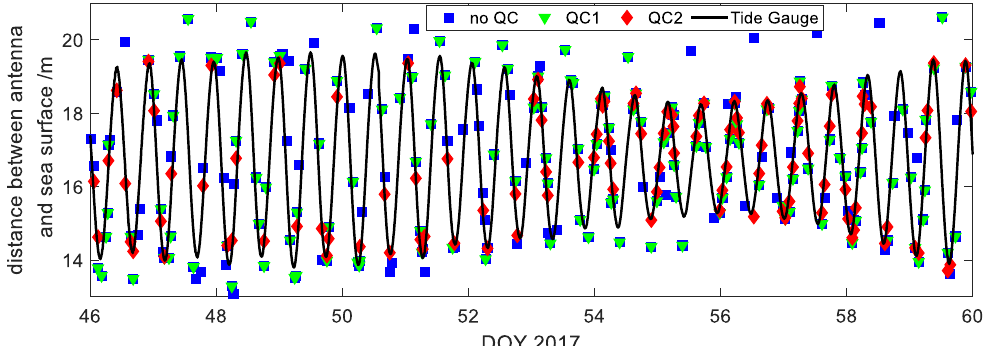
Figure 8. Comparison of different quality control methods for water level inversion at BRST Station. No QC means no quality control, QC1 refers to the threshold setting method of Ratio1, QC2 refers to the TPG method. The solid black line represents the records of tide gauge.